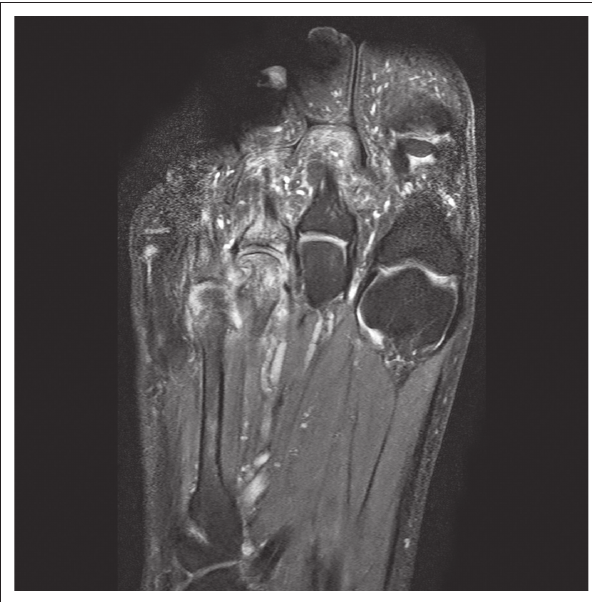
FIGURE 10: Long axis T2 FS MR image of the foot demonstrating synovitis, erosions and bone oedema in a patient with rheumatoid arthritis.